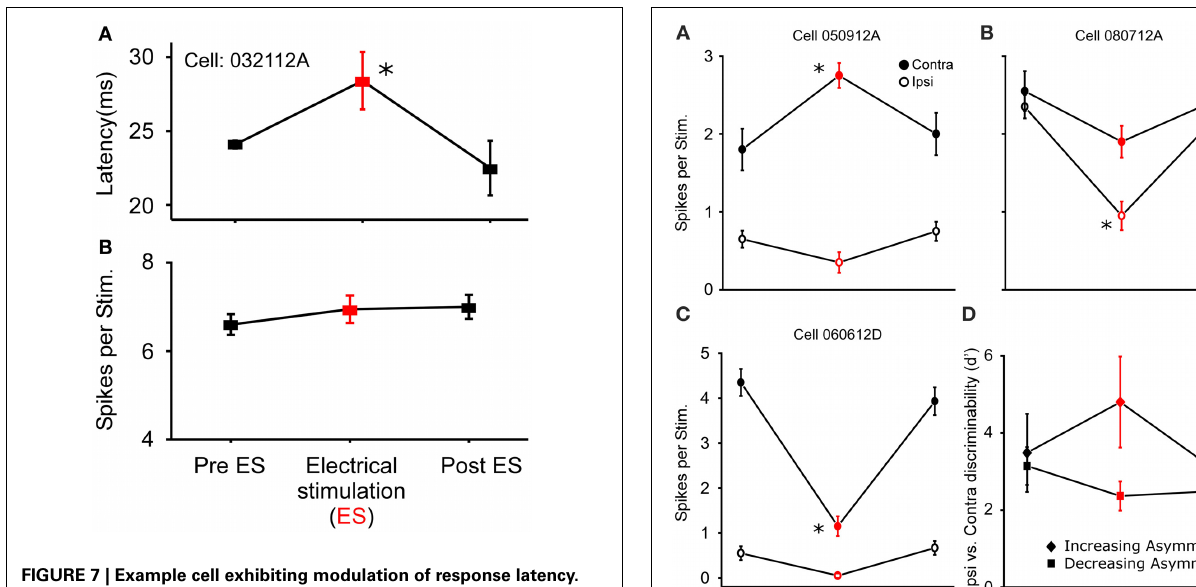
FIGURE 7 | Example cell exhibiting modulation of response latency. (A) Significant increase in first spike latency during sound-by-sound thalamic stimulation (red symbols) without change in the number of spikes/stimulus (B) . Asterisks note statistically significant modulation.